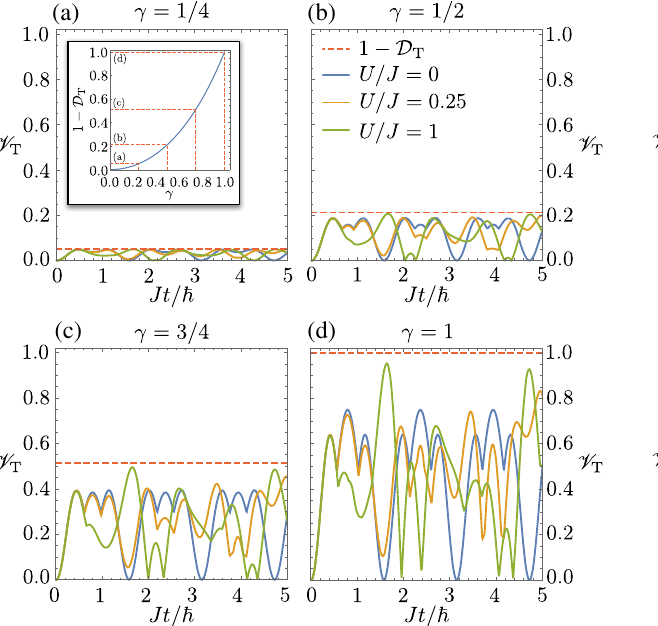
FIG. 8. Many-particle interference visibility V T in the double- well Bose-Hubbard model for the evolution time t ¼ 4 ℏ =J and tilt F ¼ J . For the particle occupation measurement M O , as well as the correlation measurements M 1 P , M 2 P , M 3 P , and M 4 P , panels (a) – (d) show the visibility V T as a function of the interaction strength U=J for γ ¼ 1 = 4 , 1 = 2 , 3 = 4 , and 1, respec- tively. Just like in Fig. 7, for all measurements and all interaction strengths U=J , the visibility V T is bounded by the particle indistinguishability 1 − D T (red dashed line). See the inset in Fig. 7(a) for the relation between 1 − D T and γ